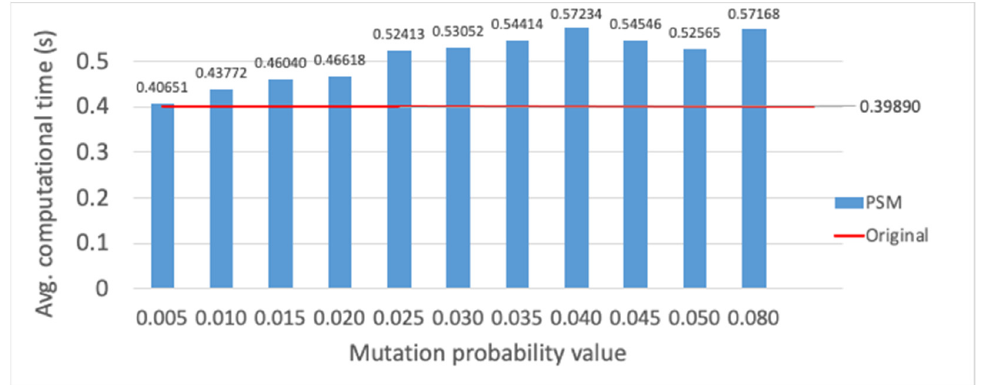
Figure 16. Average computational time (s) for PSM method vs. different mutation probability values.